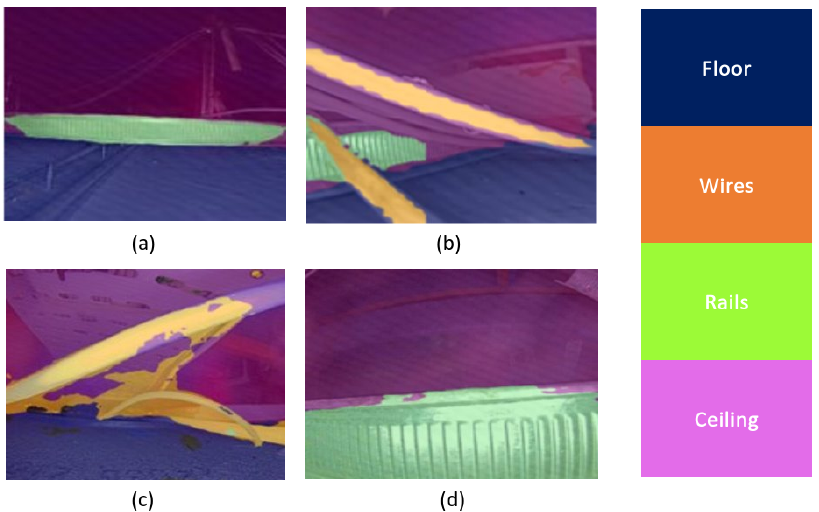
Figure 14. Offline test results of the locomotion mode recognition framework’s in the false ceiling en- vironment: ( a ) Recognition of floor, rails and ceiling, ( b ) Recognition of floor, ceiling, rails and wire, ( c ) Recognition of floor, ceiling and wires, and ( d ) Recognition of floor and rails. Table 7. Statistical measures for locomotion mode recognition framework in the false ceiling environment. Category Class Unobstructed Path